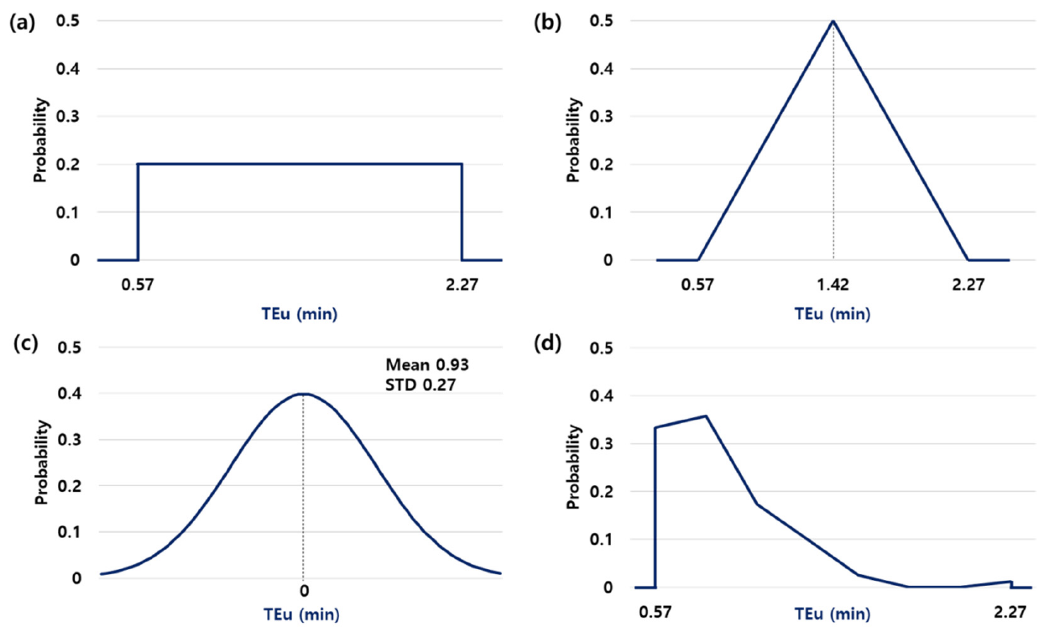
Figure 6. Probability density functions of the truck travel time for loading point 203. ( a ) Uniform distribution, ( b ) triangular distribution, ( c ) normal distribution, ( d ) observed probability distribution.